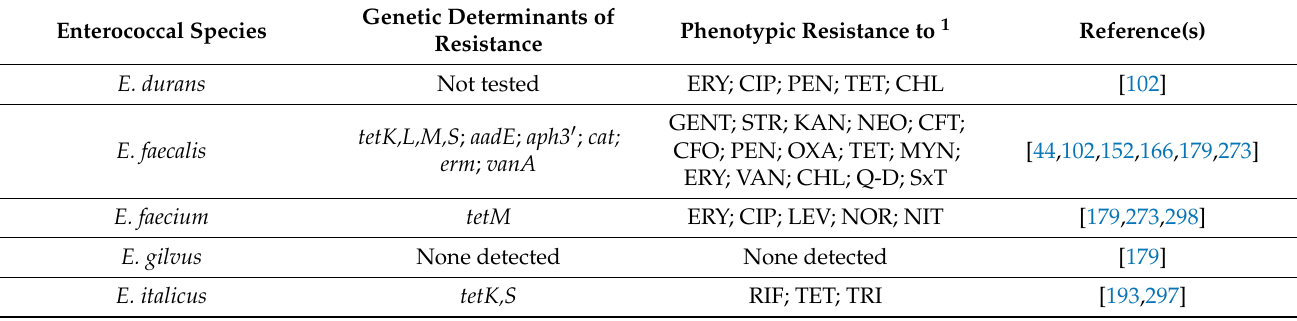
Table 2. Antibiotic-resistance determinants and phenotypes reported for enterococcal strains from traditional